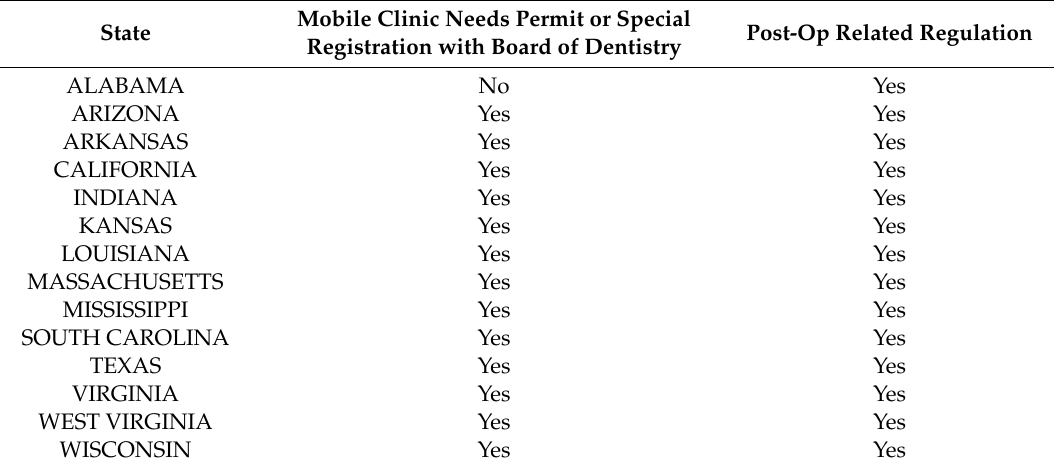
Table 1. States having specific regulations for portable